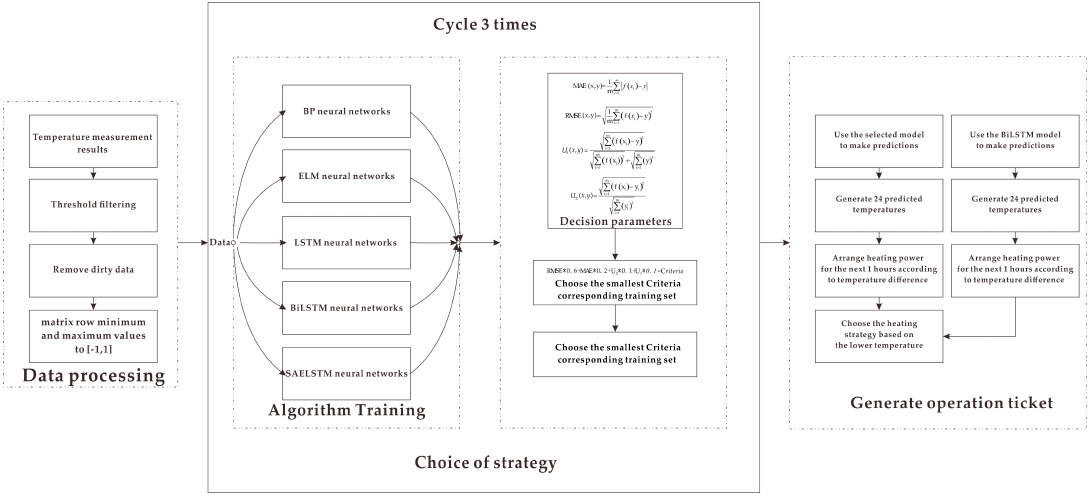
Figure 13. Predictions of 24 data after the training set.